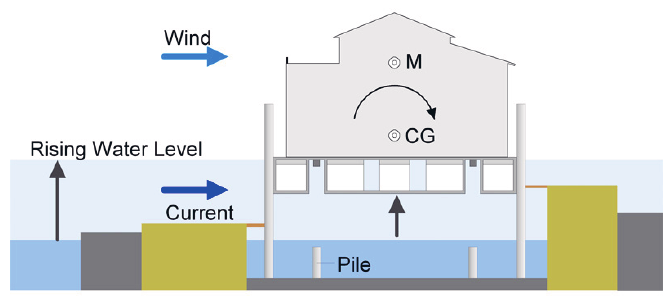
Figure 19. Schematic sectional view of upright condition of the floating